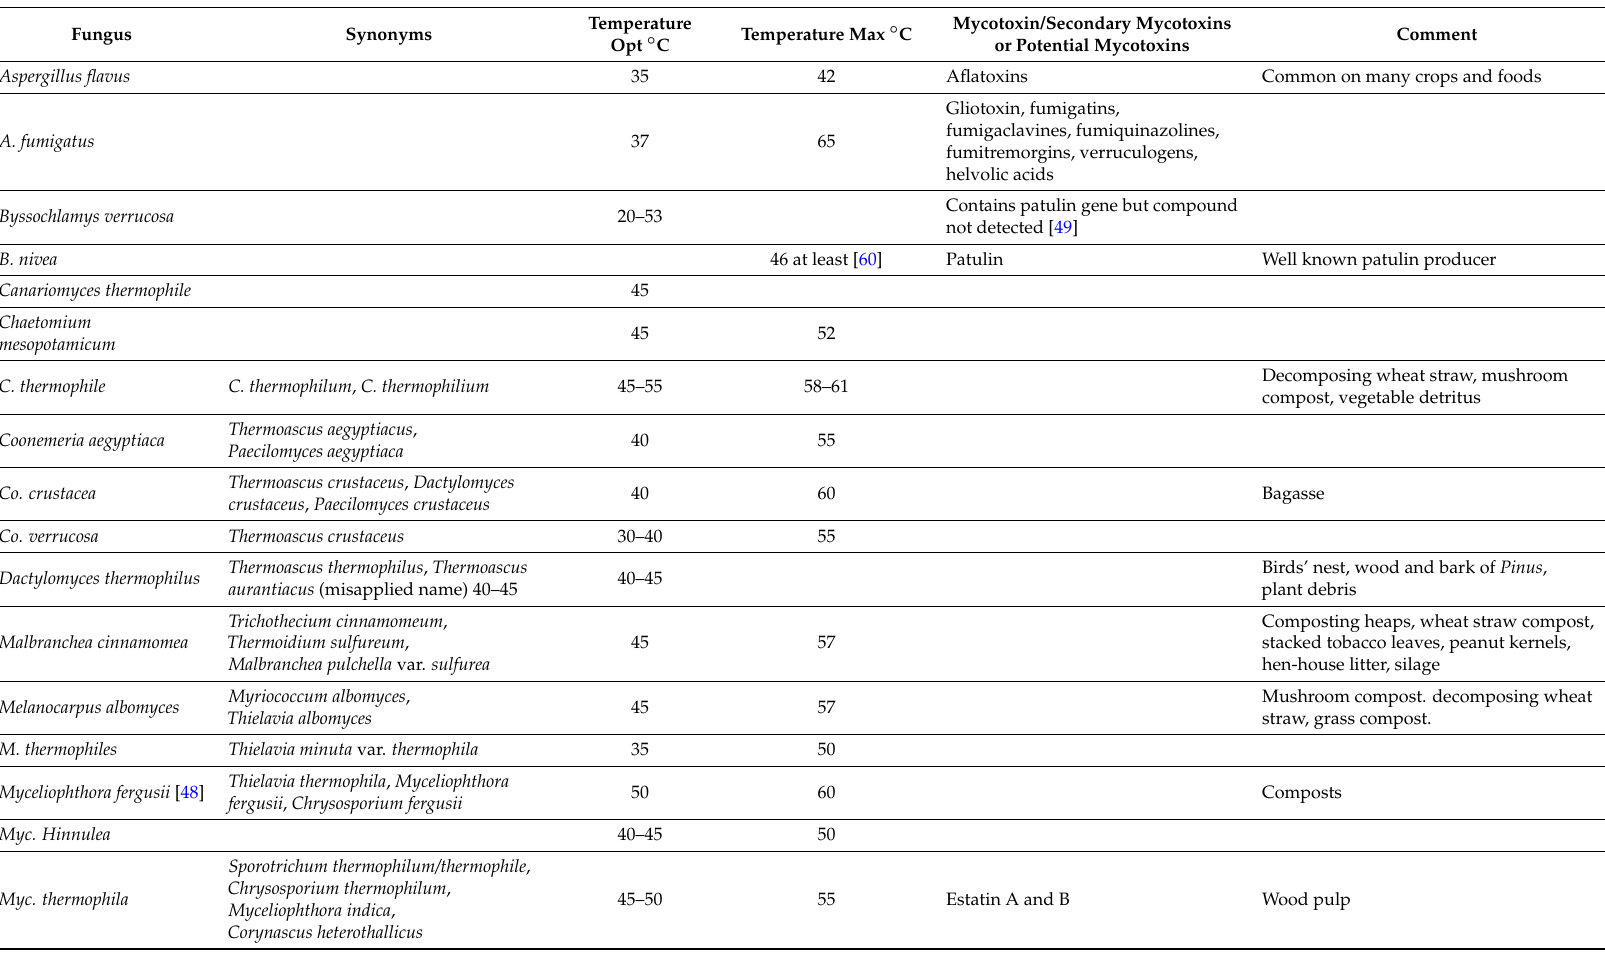
Table 1. Thermotolerant and thermophilic fungi and associated secondary metabolites (potential mycotoxins) or conventional mycotoxins that could become important with respect to climate change [57–59]. Updated names are indicated in the table by reference